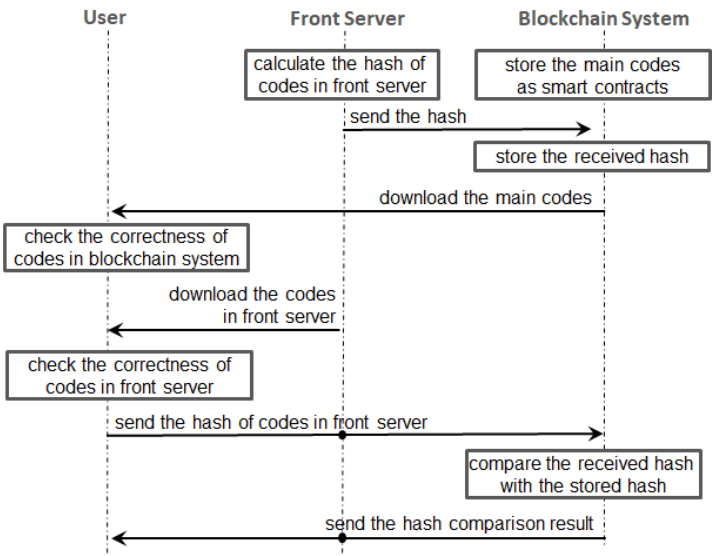
Figure 3. Procedure to check the source code reliability of the proposed scheme.